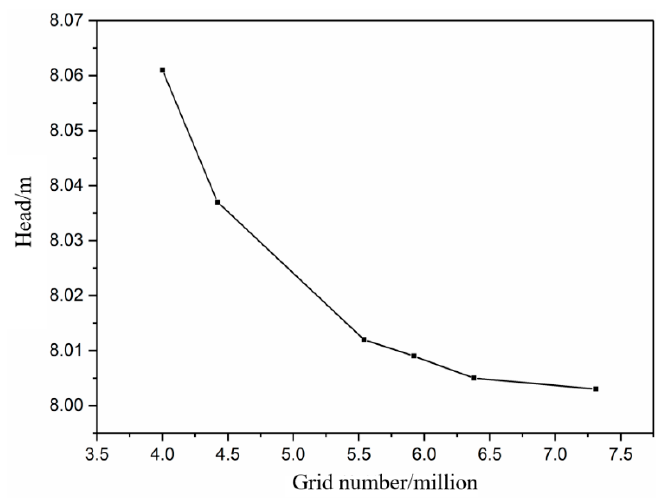
Figure 4. Head of smooth centrifugal pump with different grid number.